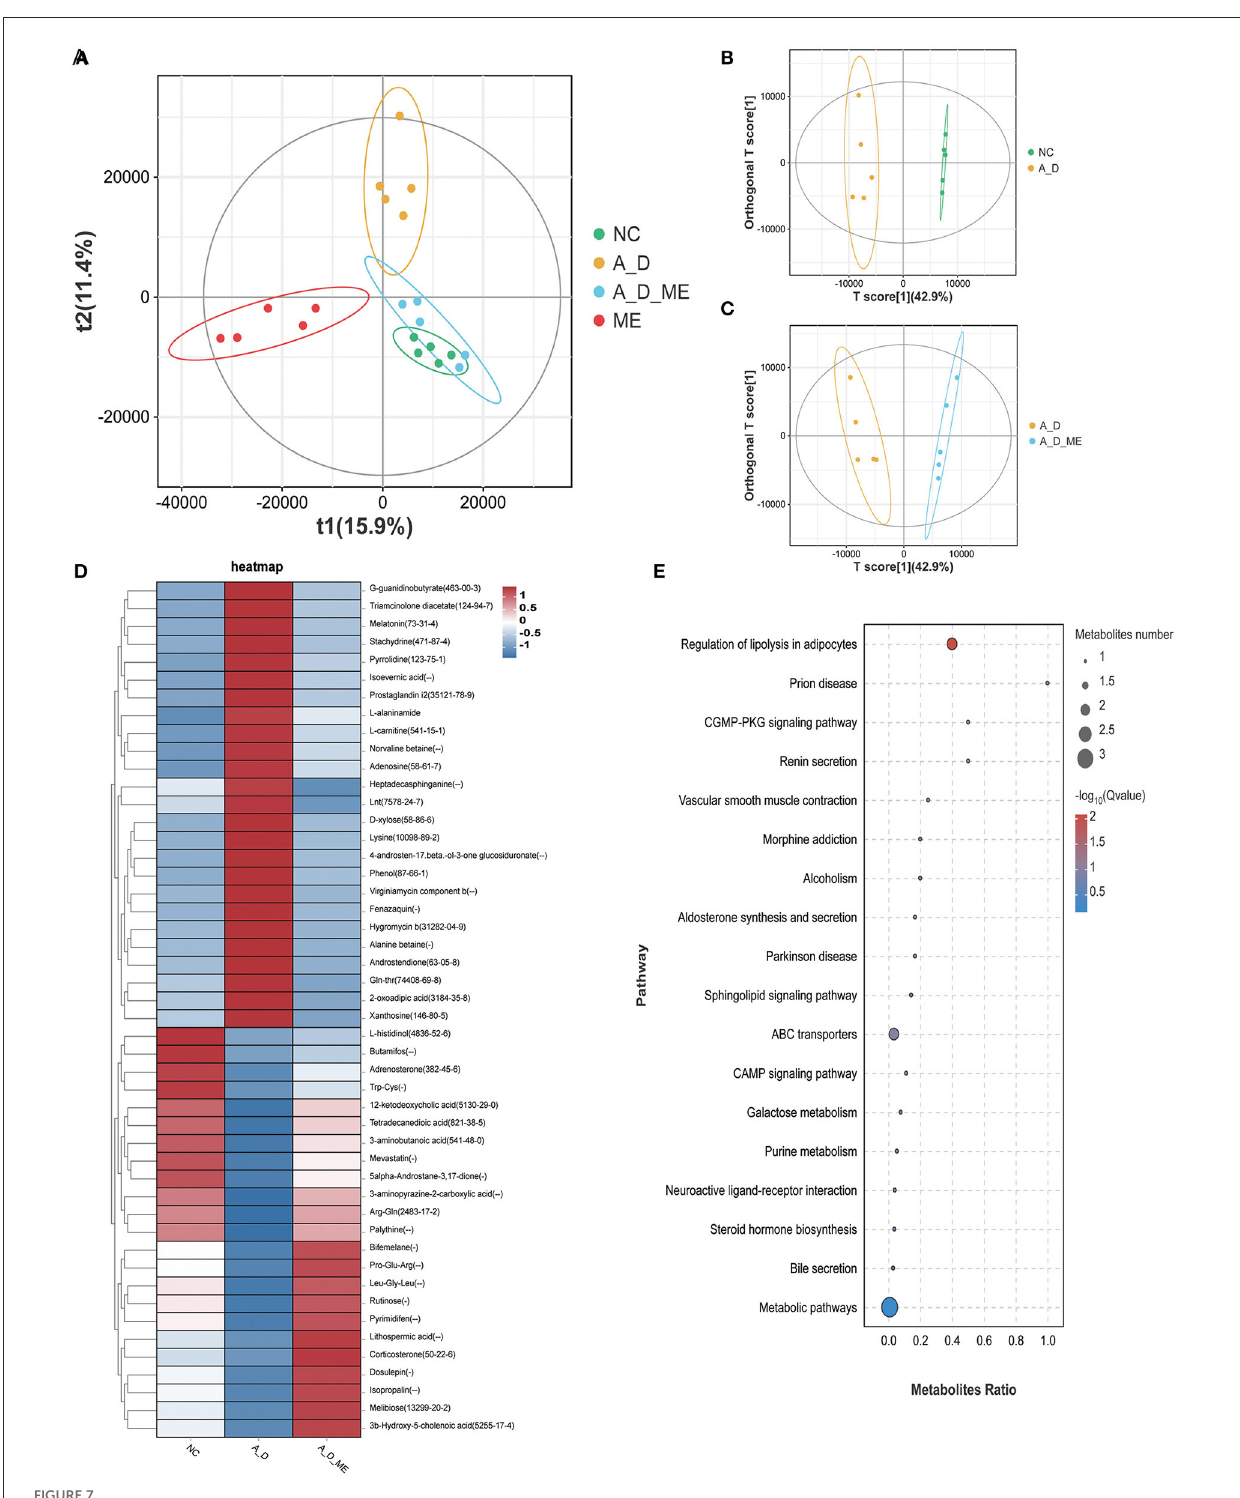
FIGURE7 Alteration of ME administration on metabolomics in the fecal. score scatter plots for (PLS-DA) the model showed that almost all of the data is in 95% hotelling’s T-squared ellipse. The X and Y axes are the scores of the first and second principal components (A) . Combining orthogonal signal correction (OSC) and PLS-DA, the X matrix information can be decomposed into two types of information related to Y and irrelevant. By removing the irrelevant differences, the relevant information is concentrated in the first predictive component (the predicted score of the X-axis). The Y axis represents the score of the main orthogonal component. An orthogonal projection to latent structures-discriminant analysis (OPLS-DA) model was employed to analyze and screen differential metabolites. NC vs. A_D (B) , A_D vs. A_D_ME (C) . (D) heatmap of 48 differential metabolites enriched in the three groups, (E) bubble map of KEGG enrichment pathway. The top 20 pathways with the lowest Q value are used to draw the map. The X axis is the pathway and the Y axis is the ratio of the metabolites (the number of differential metabolites in the pathway divided by all the numbers in the pathway). The size stands for the number and the color stands for the Q value. N = 5 mice per